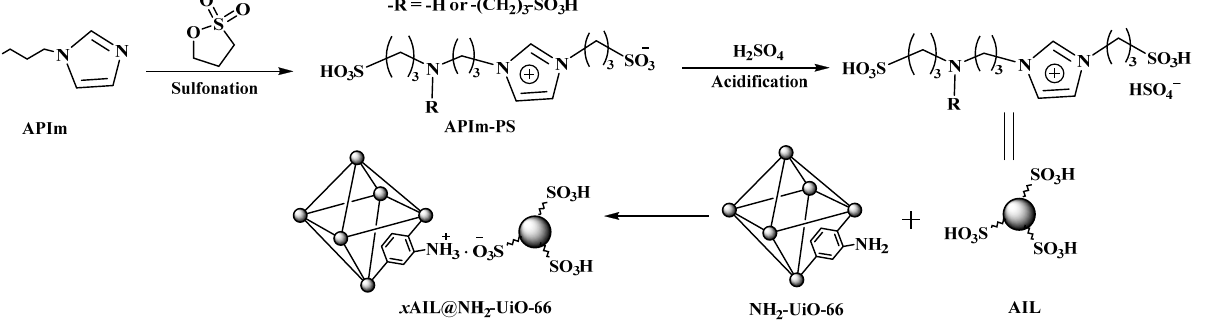
Figure 5. The suggested structures for AIL and x AIL@NH 2 -UiO-66 (where x indicates the mass ratio of AIL to NH 2 -UiO-66).